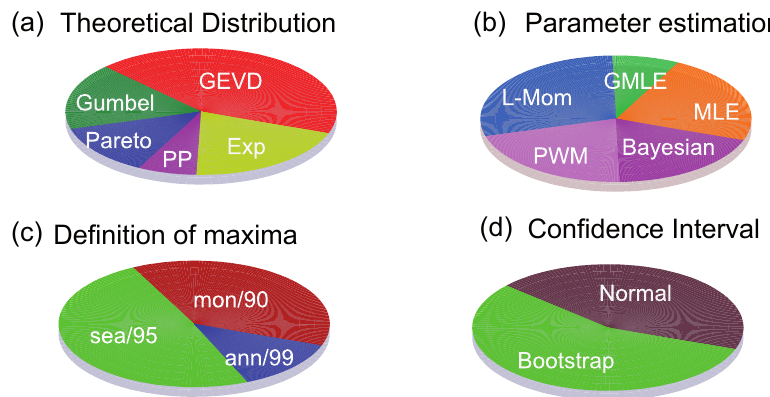
Figure 6. Pie-plots representing the rate of successful experiments for each methodological variant: the respective proportion of remaining experiments after applying filters from MD1 to MD6 according to ( a ) the corresponding family distribution, ( b ) the parameters estimation method, ( c ) the criterion to select the wind extremes and ( d ) the method to estimate the confidence intervals.